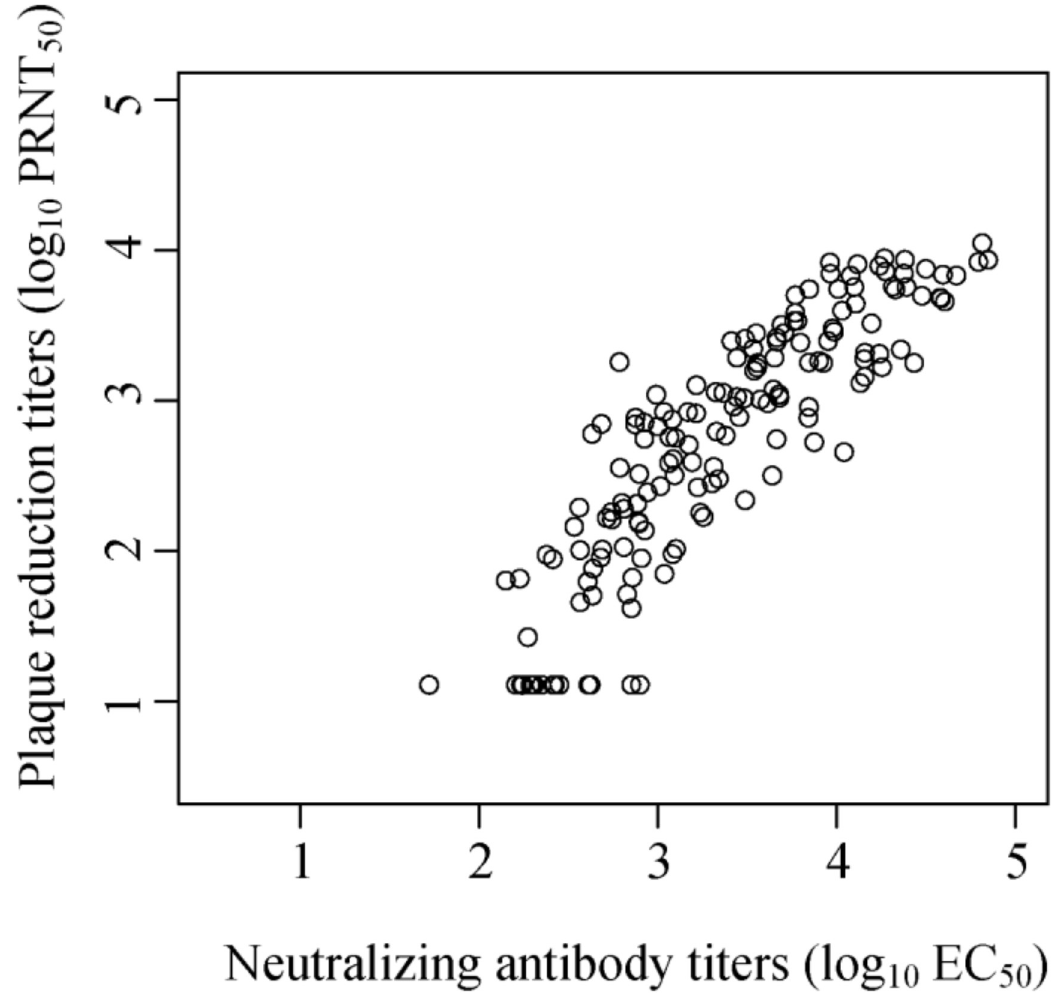
Fig 10. Correlation of ZIKV neutralization titers in human sera using Z-PRNT and Z-RVP-384 assays. Human sera from a clinical trial of PIZV (ZIK-101) day 29 (post dose one sera) and day 57 (post dose two sera) were tested in both Z-PRNT (Y axis) and Z-RVP-384 (X-axis) and log 10 -transformed titers plotted. A Spearman correlation analysis was conducted in R and showed a strong correlation of